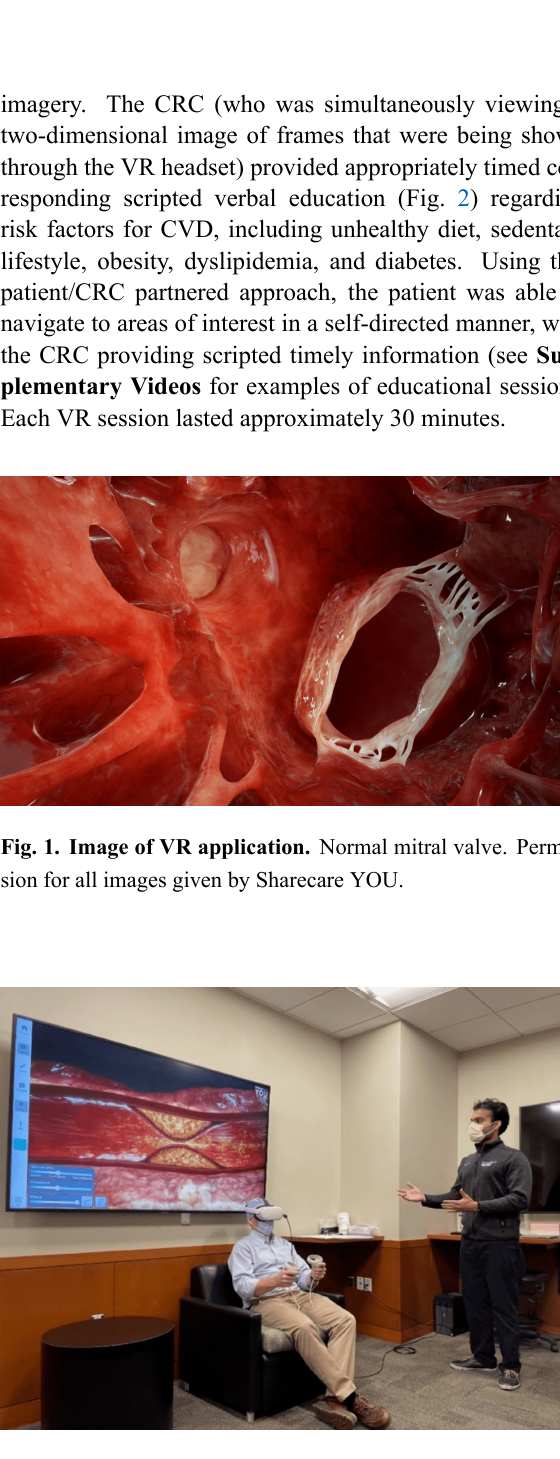
Fig. 2. Patient learning about coronary heart disease risk fac- tors during a VR